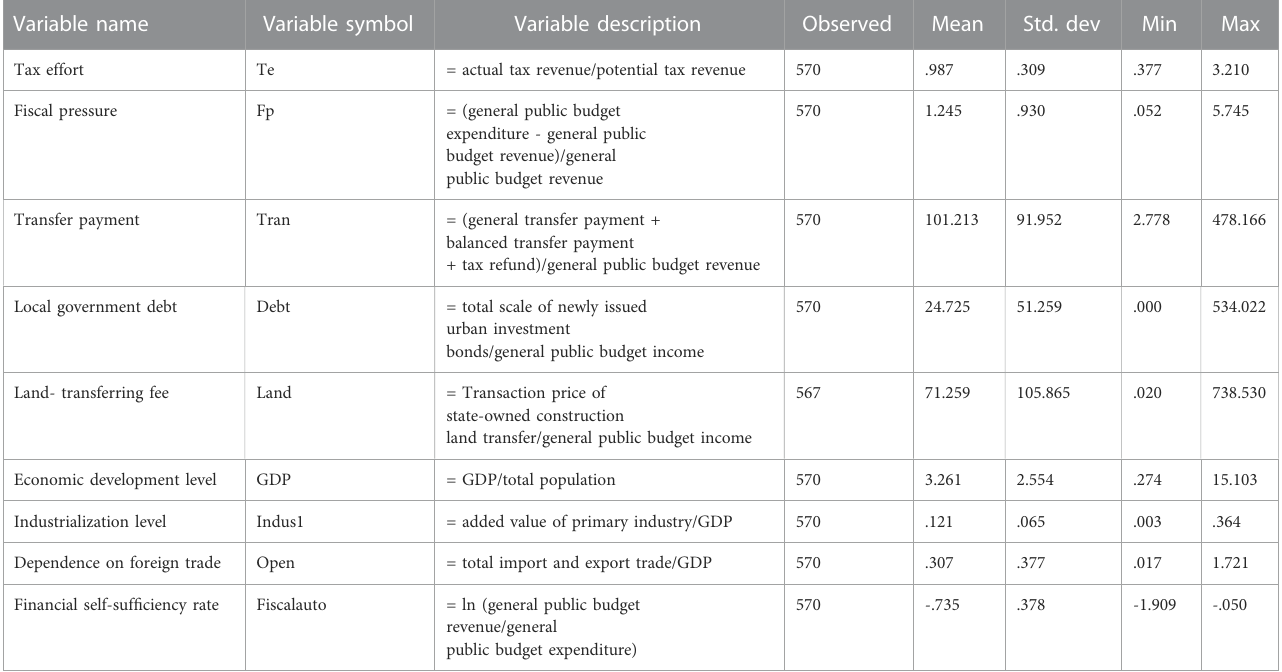
TABLE 1 Descriptive statistics of